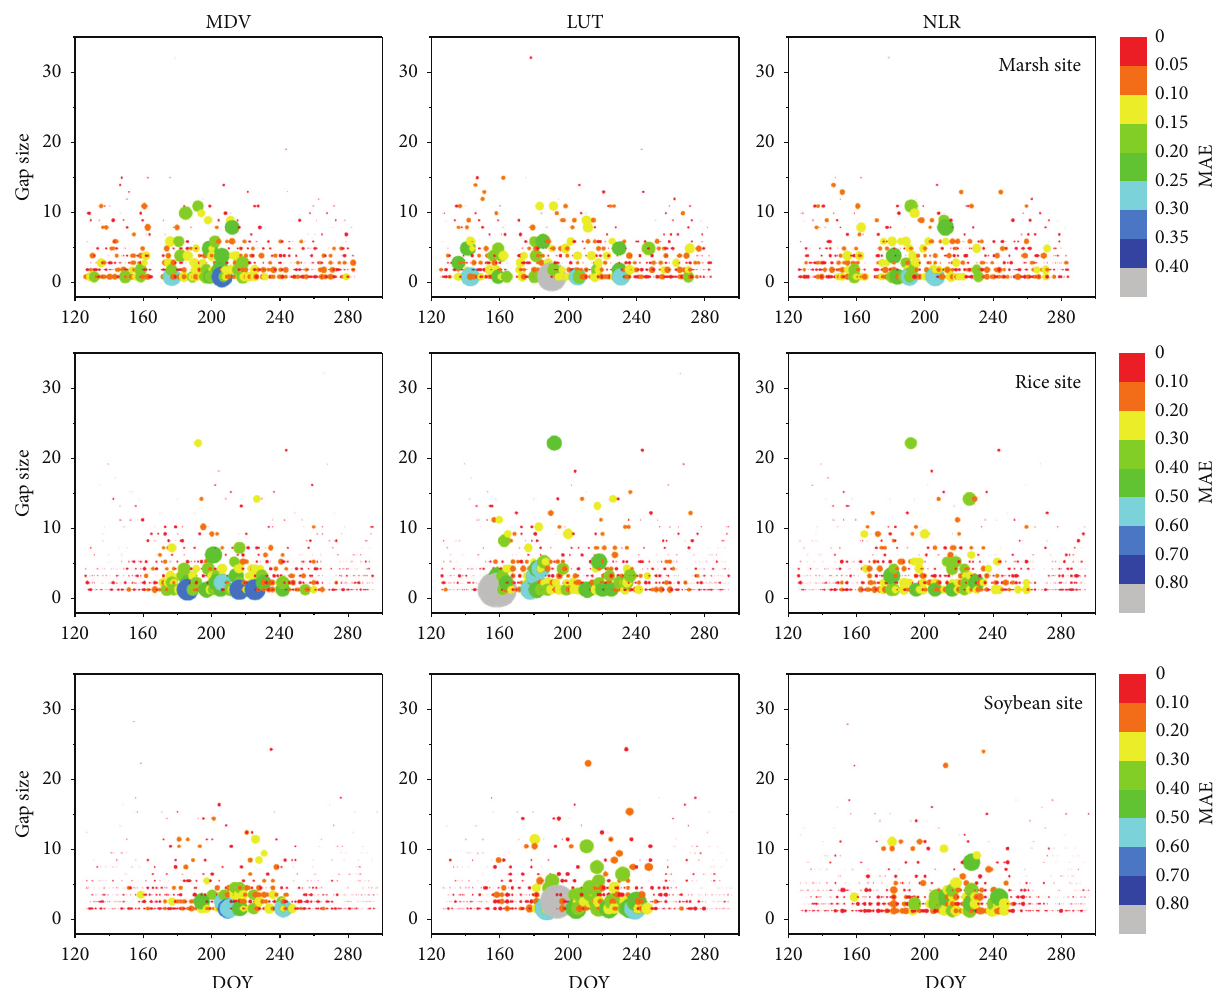
Figure 6: Two-dimensional plots illustrating mean absolute error (MAE) in gap-filled NEE, expressed as MAE, varied as a function of day of year ( 𝑥 axis ) and gap length ( 𝑦 axis ). Plots in row were shown for marsh, rice, and soybean sites, and plots in column were shown for MDV, LUT, and NLR methods. The different size and color of the circle refer to magnitude of MAE, and unit is mgCO 2 m −2 s −1 .